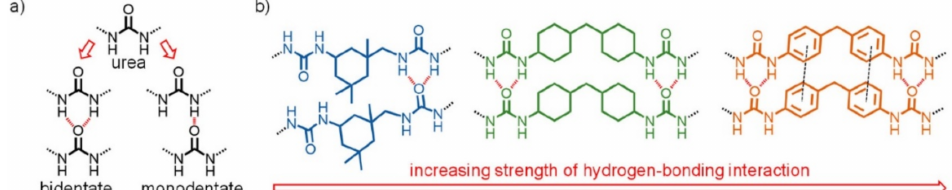
Figure 12. ( a ) Various H-bond interactions in ureas. ( b ) H-bond interactions in the PDMS-based poly(urea)s depending on their strength. Reprinted with permission from [135]. Copyright (2020) American Chemical